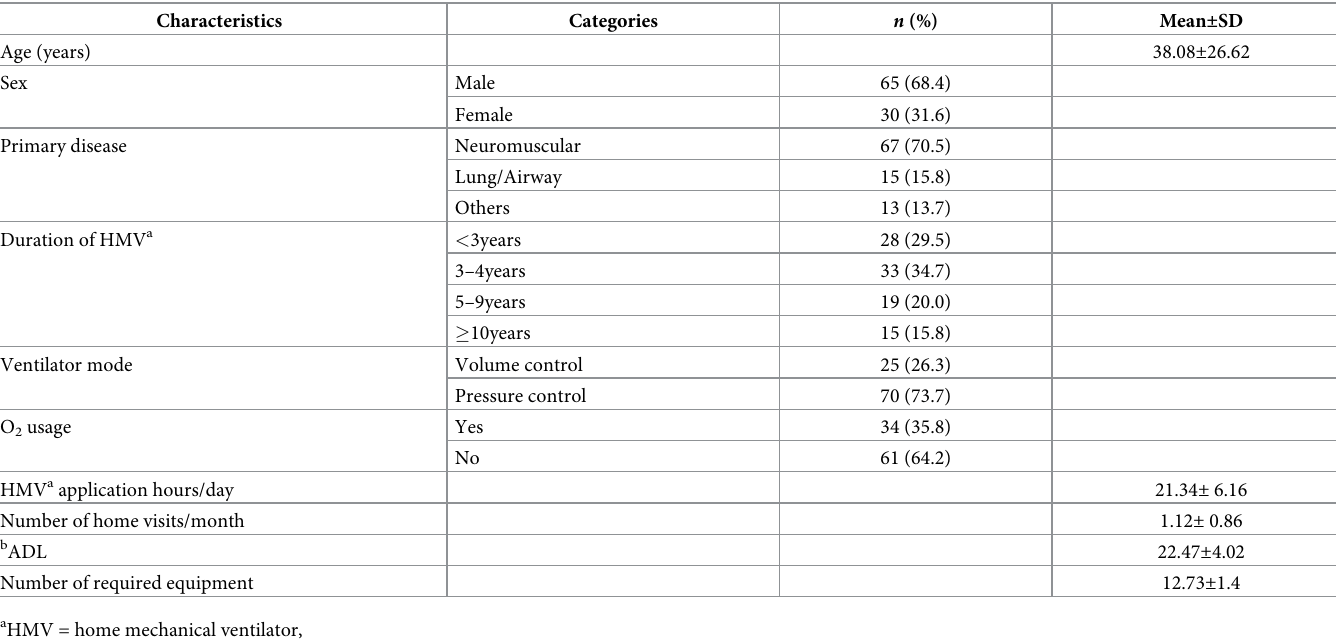
Table 2. General and disease-specific characteristics of patients (n = 95). Characteristics